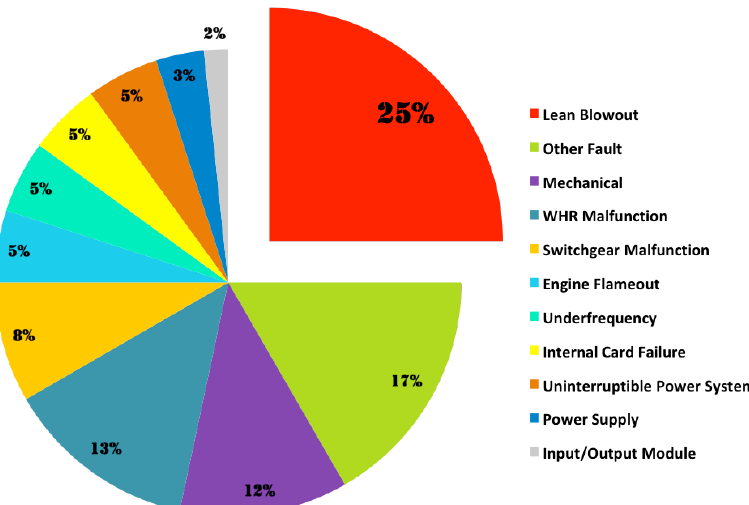
Figure 18. Gas turbine trips cause in GDC plant.